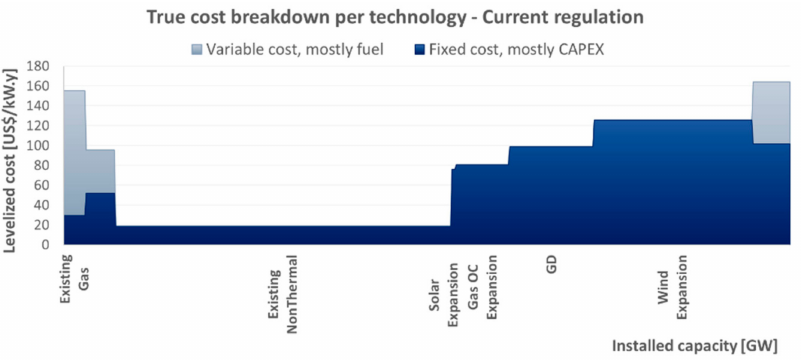
Figure 15. Cost breakdown in the current regulation scenario. Total cost (variable + fixed) equal to USD 24.2 billion.